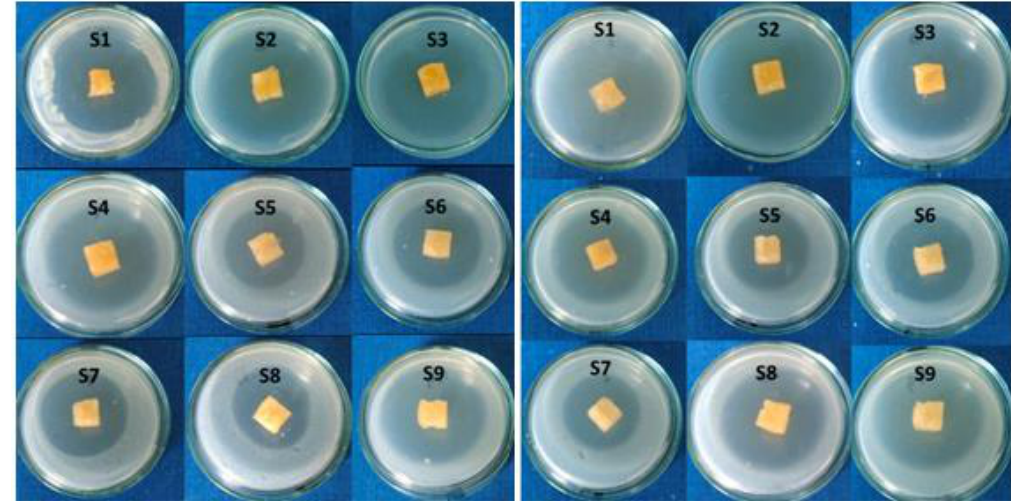
Figure 8. Antimicrobial activity against Escherichia coli ( left side ) and Staphylococcus aureus ( right side ). Table 3. The evaluation of the antimicrobial activity of the citrate-salecan